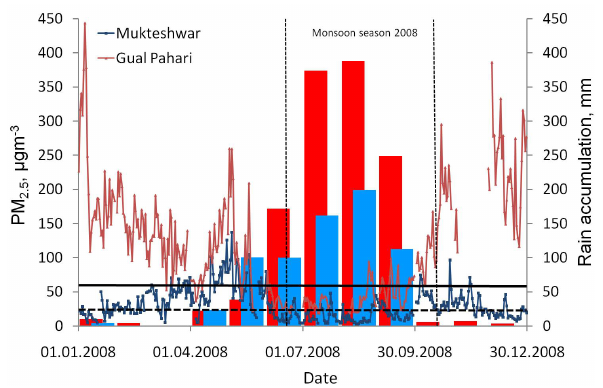
Fig. 4. PM 2 . 5 and rain accumulation at Mukteshwar and Gual Pa- hari during 2008. Solid lines denote daily 24h PM concentrations, dotted lines monthly rain accumulation. The black line is the Indian national 24h ambient air quality PM 2 . 5 standard of 60µgm − 3 , the dotted line the corresponding WHO guideline of 25µgm − 3 . Con- centrations are in ambient conditions.